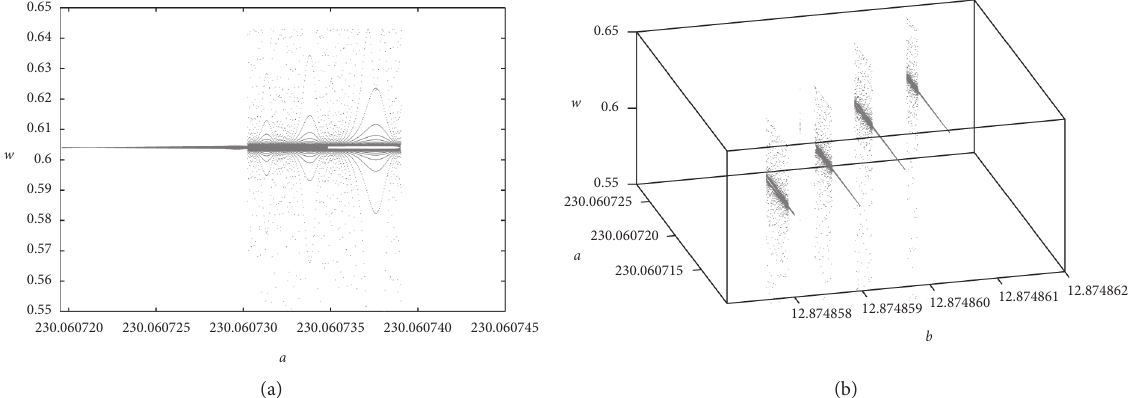
Figure 1: 1: 2 strong resonance bifurcation diagram at (0.603987, 0.535162): (a) in ( a − w ) plane with b � 12 . 87486 and (b) in ( b − a − w ) space.